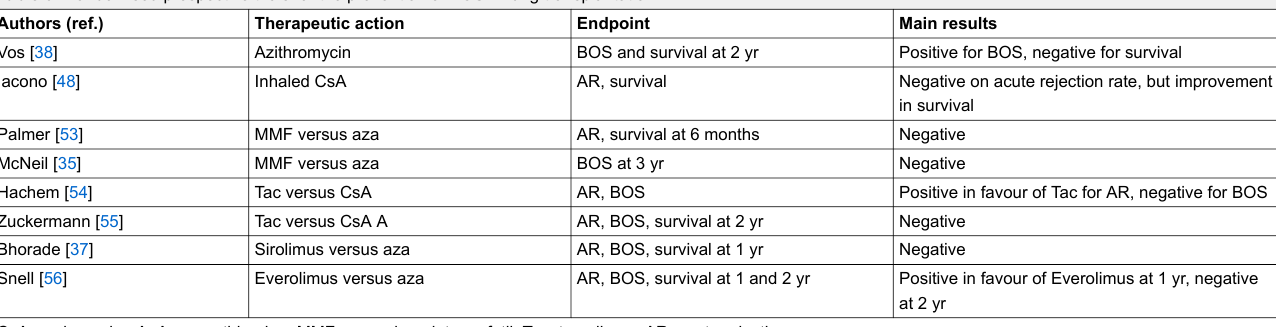
Table 3: Randomised prospective trials for the prevention of BOS in lung transplantation. Authors